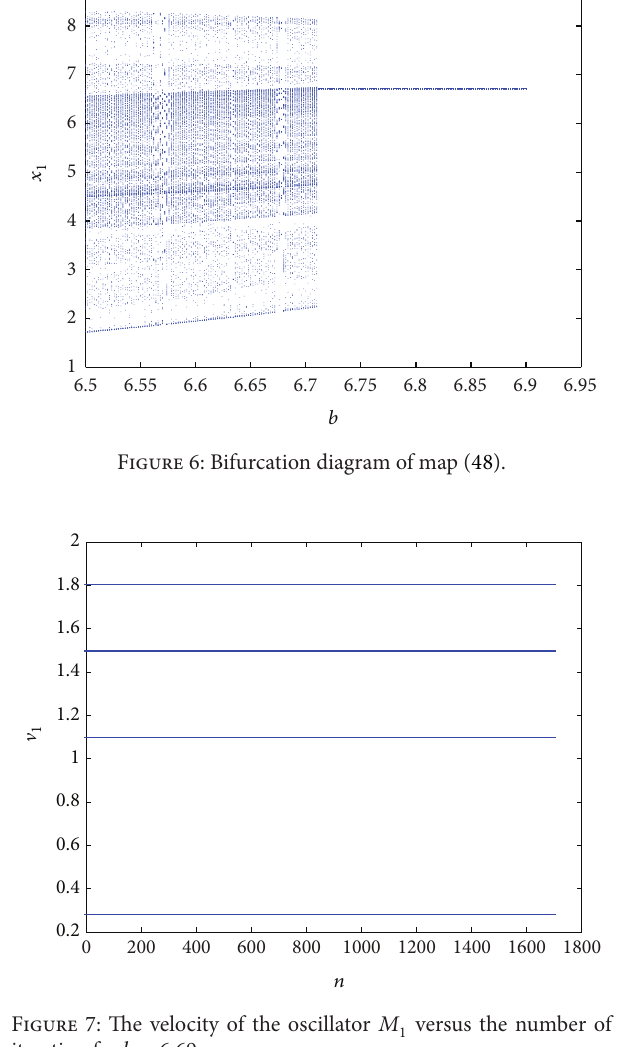
Figure 9: Phase portrait of the oscillator 𝑀 1 with 𝑏 = 6.8 .